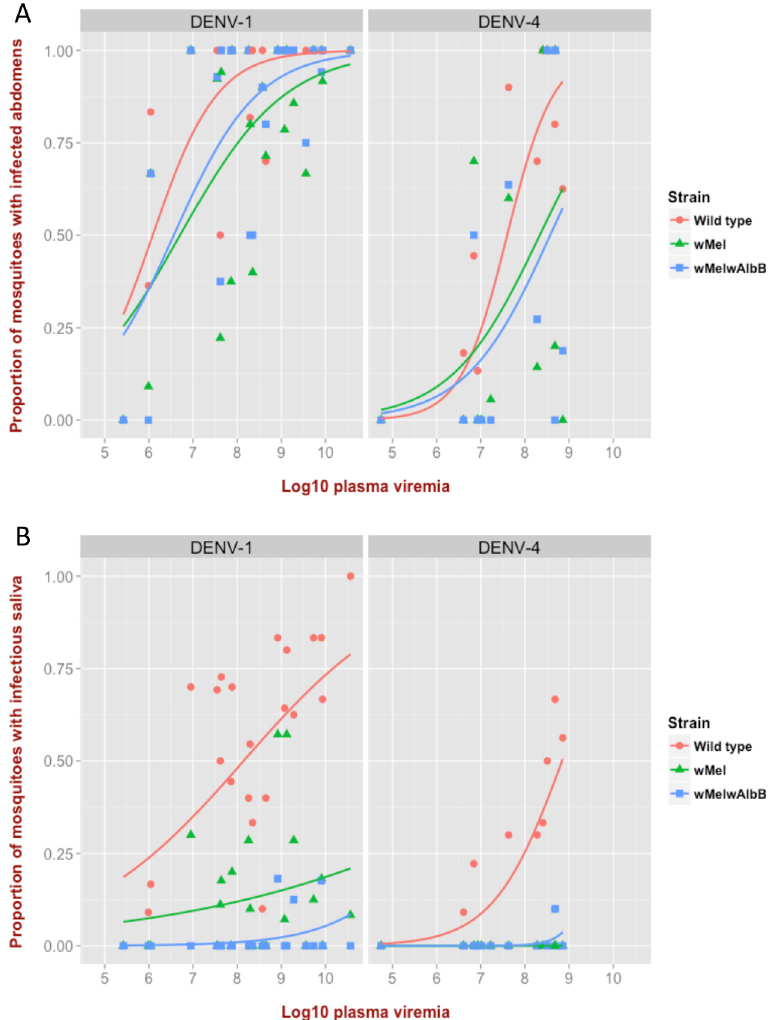
Fig 5. Proportion of mosquitoes infected with DENV after blood-feeding on 36 dengue patient blood samples, as a function of plasma viremia, and stratified by serotype. Lines represent fits from logistic regression to the data. All three strains were assessed for every feed; for DENV-1 there were 23 blood feeds, and 13 for DENV-4. DENV-2 and DENV-3 are not represented due to small sample sizes (n = 3 and n = 2 respectively). (A) Each point represents the proportion of mosquitoes with a DENV-infected abdomen, stratified by strain, and pooled across all time points. (B) The proportion of mosquitoes, pooled across all time points, that expectorated infectious DENV in their